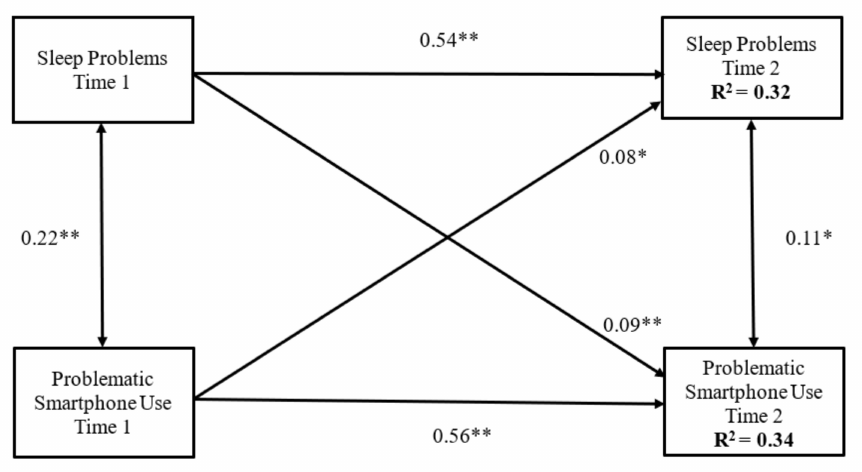
Figure 1. The cross-lagged analyses between sleep problems and problematic smartphone use. The model controlled for school types, parents’ education level, and parents’ job status. ** p < 0.001. * p <